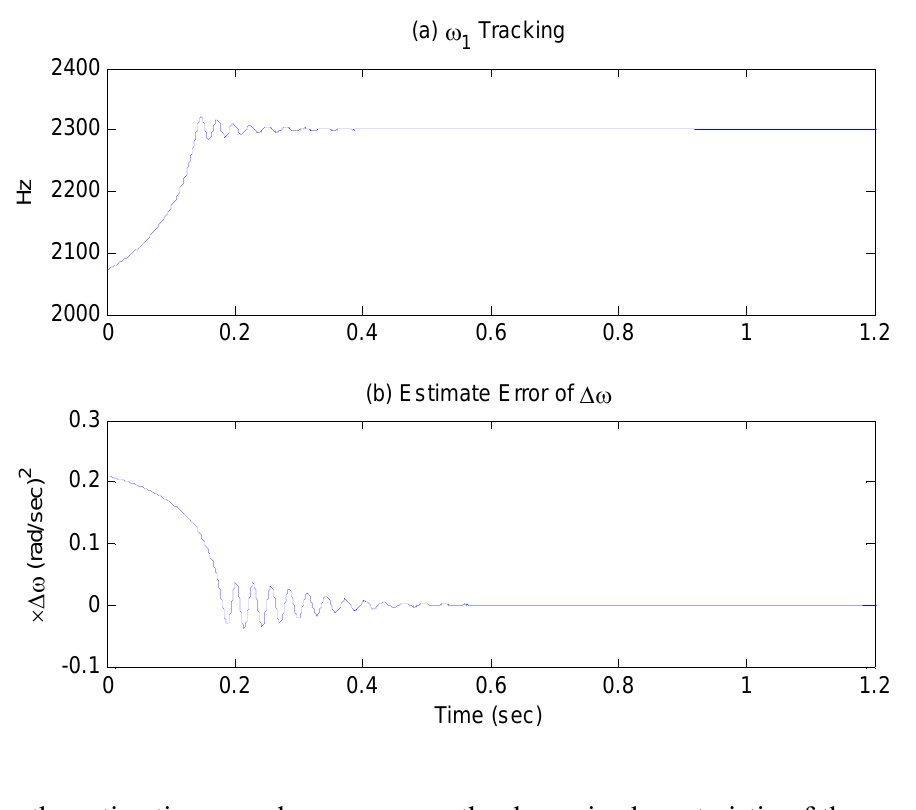
Figure 3. (a) Excitation frequency, (b) Estimation error of the frequency